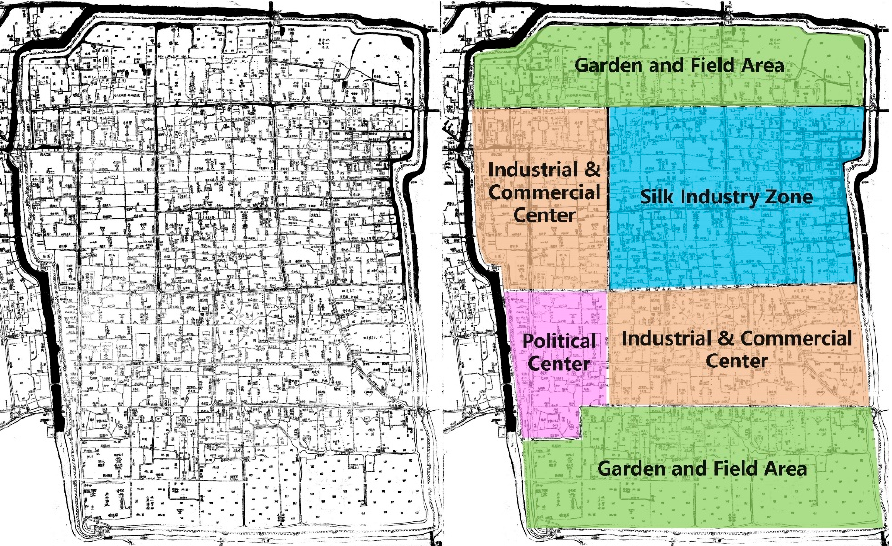
Figure 1. The Map of Suzhou City and its spatial distribution.